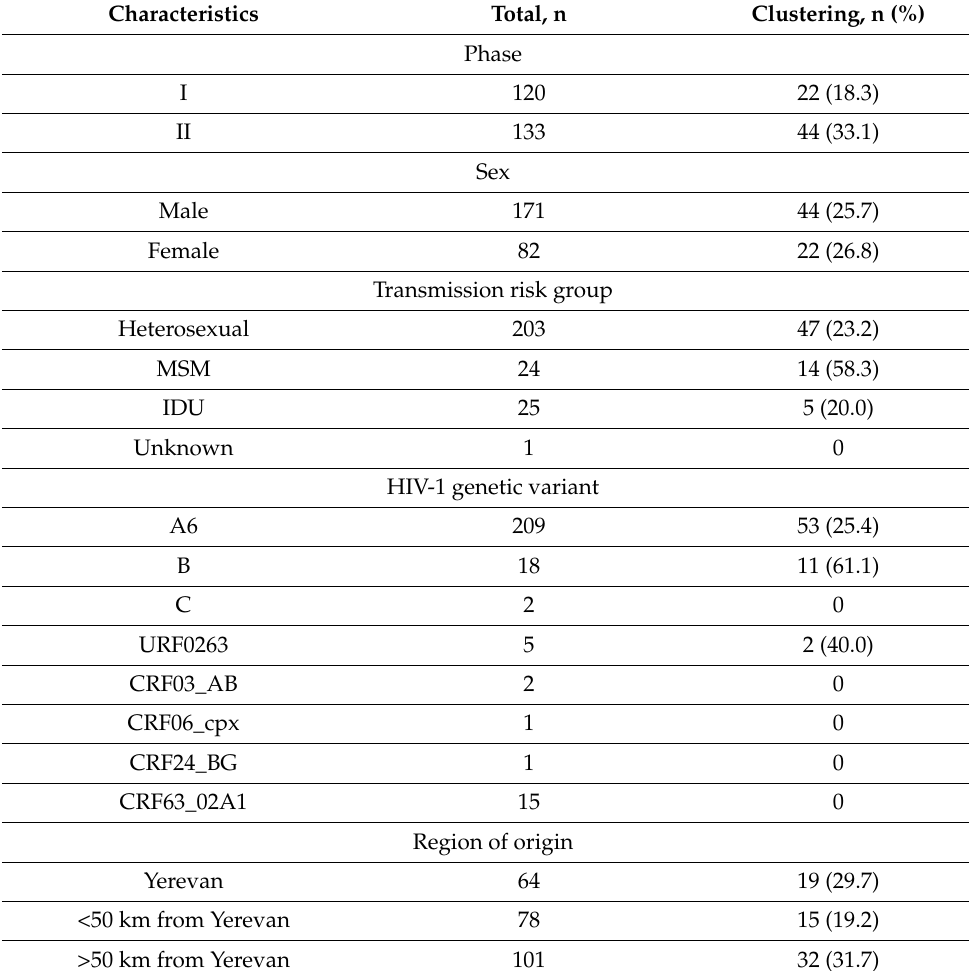
Table 4. Factors associated with transmission within